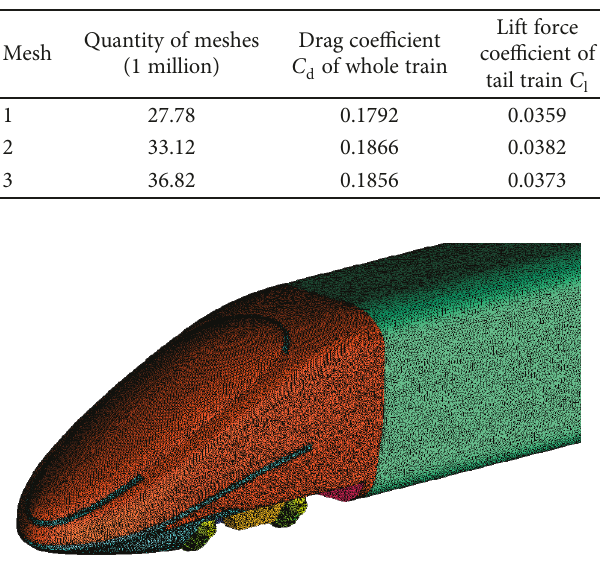
Figure 8: Meshes of head train of high-speed